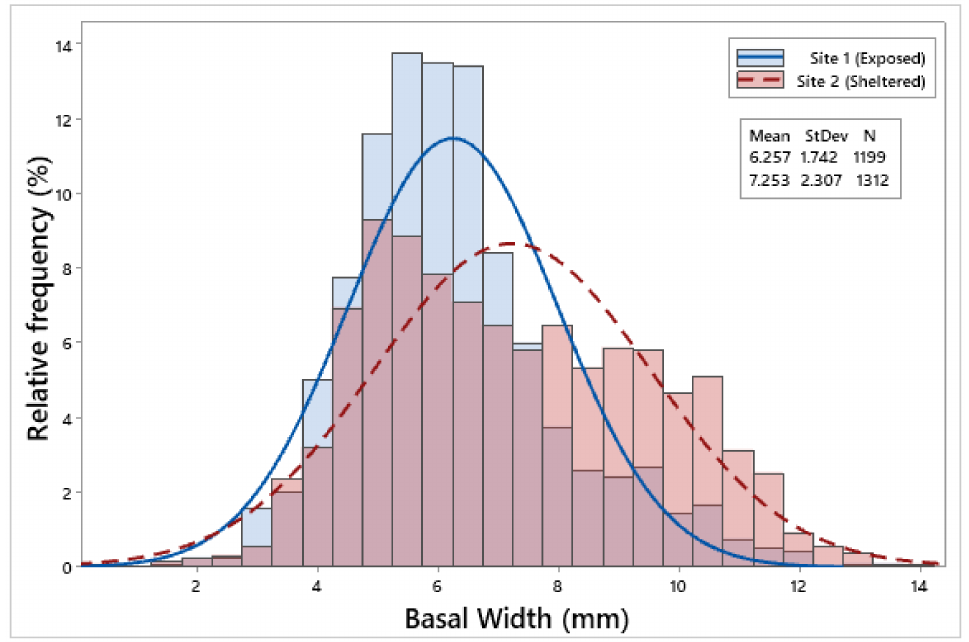
Figure 4. Basal width–frequency distribution of C. stellatus populations with overlaid fitted normal distribution at both sampling sites.